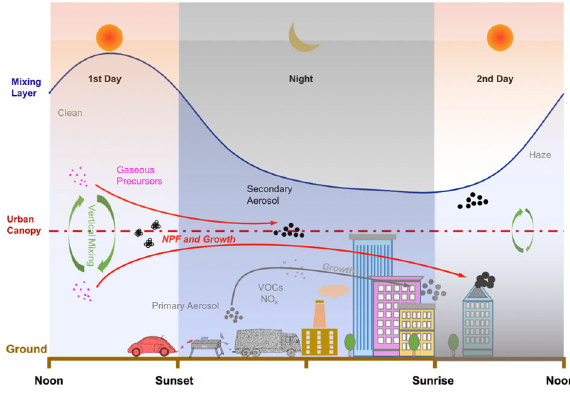
Fig. 5 Schematic plot to show enhanced particle growth by local primary emissions contribute to more severe haze at ground level. Blue line: Mixing layer. Red dash line: Urban canopy. Two main processes are illustrated here: 1) the growth process of particles originating from new particle formation (NPF) (red line with arrow). This growth process lasts for a longer time and reaches a larger size at ground level due to a higher availability of condensing vapors provided by local emissions. 2) the growth process of local primary particles at ground level (black line with arrow). These two processes and the less effective boundary layer mixing (green line with arrow) together lead to more severe haze at ground